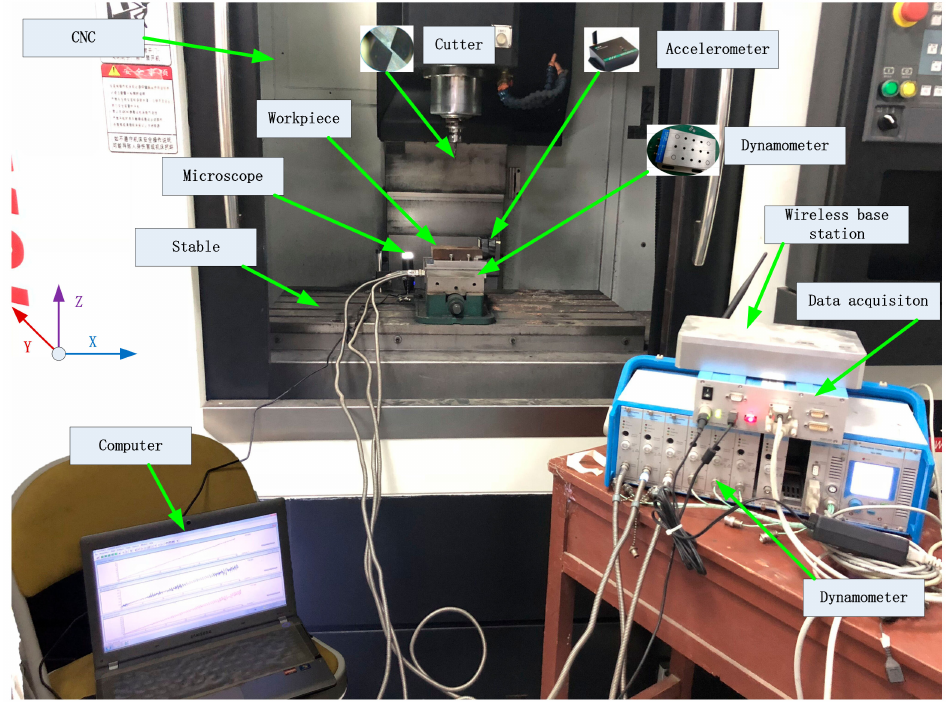
Figure 6. The experimental